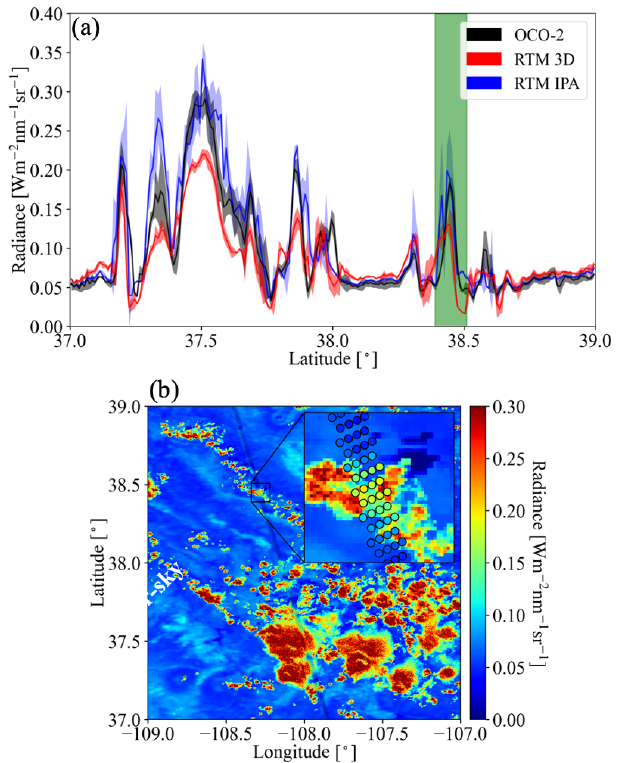
Figure 5. (a) Latitudinally averaged (0.01 ◦ spacing) radiance cal- culations from EaR 3 T (red: 3D; blue: IPA) and OCO-2 measured radiance at 768.52nm (black) The green shaded area indicates the inset shown in (b) . (b) The same as Fig. 2 except OCO-2 measured radiance overlaid on IPA radiance simulations at 768.52nm. The solar zenith angle (SZA) for the radiance simulation case is 34.3 ◦